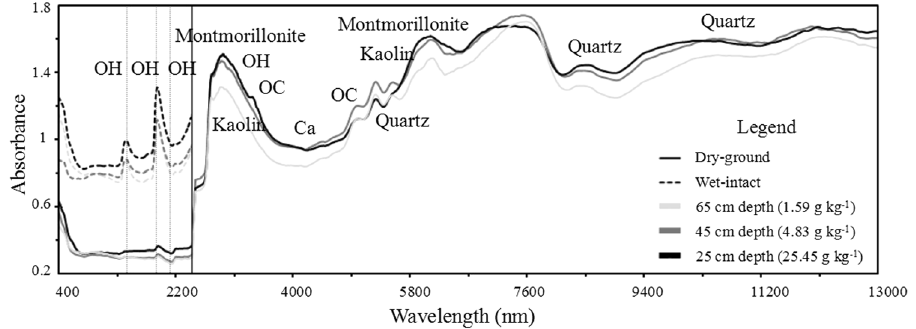
Figure 2. The absorbance spectra at different depths with different contents in one soil core of shrub meadow in the VNIR and MIR regions. OH is the atomic group consisting of oxygen atoms and hydrogen atoms, and OC is the atomic group consisting of oxygen and carbon atoms. The SOC contents in the 65 cm, 45 cm and 25 cm depths were 1.59 g kg − 1 , 4.83 g kg − 1 , 25.45 g kg − 1 , respectively.